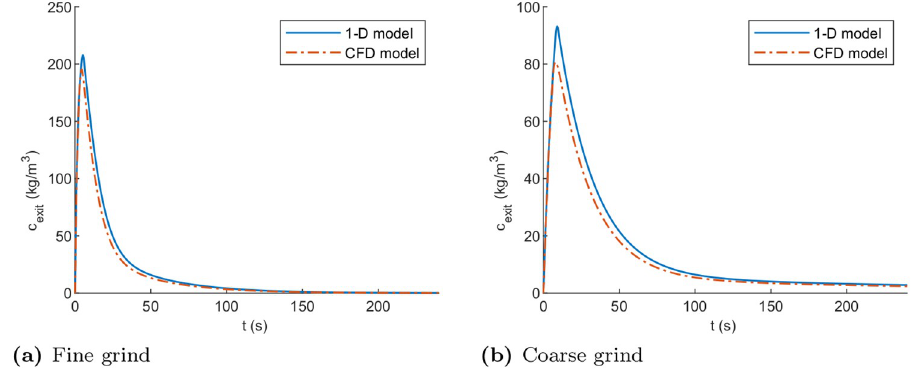
Fig 8. Numerical simulations for conical case. Comparison of numerical models of coffee extraction in the conical geometry using the two grain model for the fine and coarse grinds. Parameters listed in Table 2.